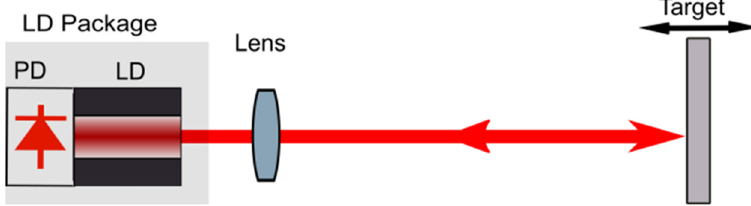
Figure 1. Basic structure of a laser with external optical feedback.